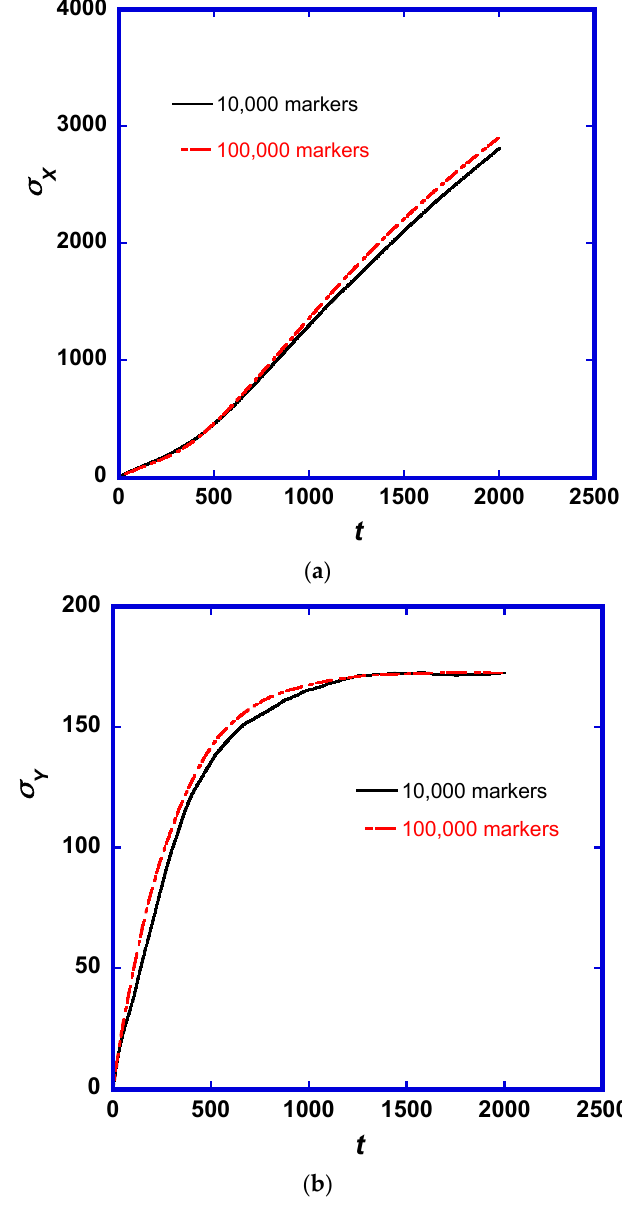
Figure 5. Standard deviation of the scalar marker location in the ( a ) streamwise direction, x , and ( b ) wall normal direction, y . Two experiments with 10,000 and 100,000 markers are presented, for Pr = 6.